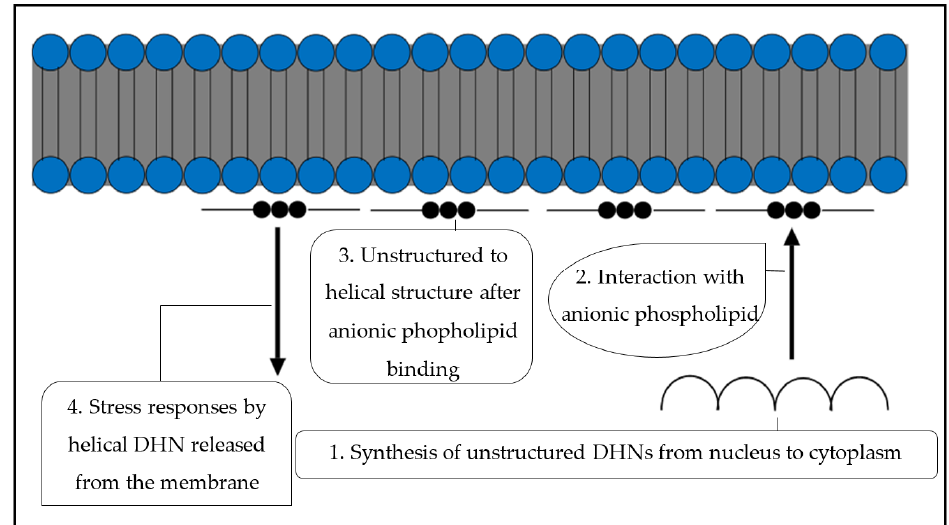
Figure 5 . Binding of DHNs to membrane phospholipids. The unstructured DHNs that are synthesized during an abiotic stress in the cytoplasm move close to the cell membranes. Through their phospholipid binding property, the unstructured DHNs bind to the membrane’s anionic phospholipids, attain a helical structure, and generate stress responses. The stress responses include structured DHNs that bind to other stress-sensitive protein molecules and protect them from the damage caused by the stress.